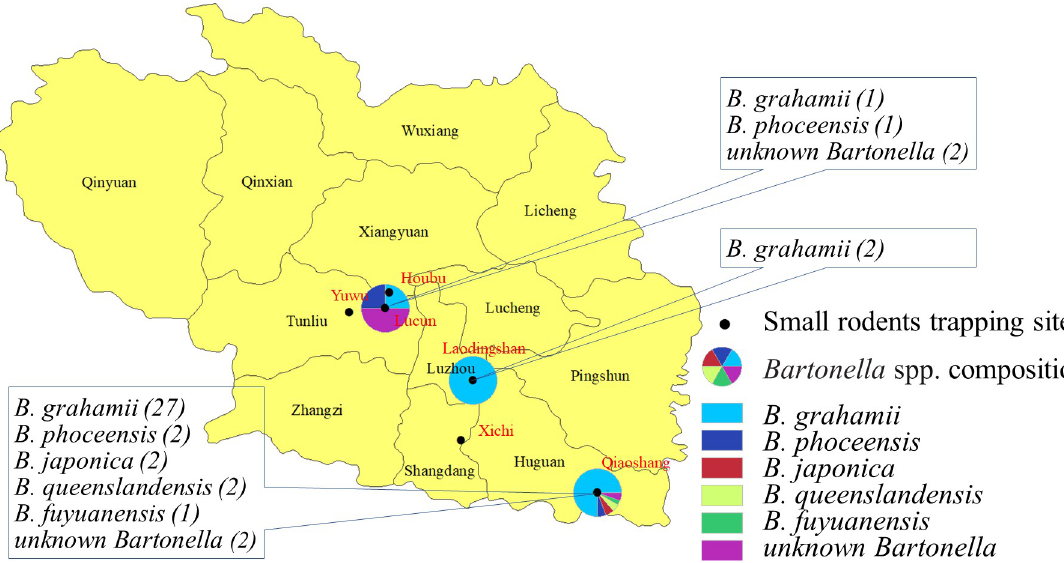
Fig 4. Bartonella species composition in different sampling sites in the Shangdang Basin, China. The map was prepared in ArcGIS 10.2.2 using political boundaries from the National Geomatics Center of China (http://www.ngcc.cn/ngcc) for illustrative purposes only, these data are available free of